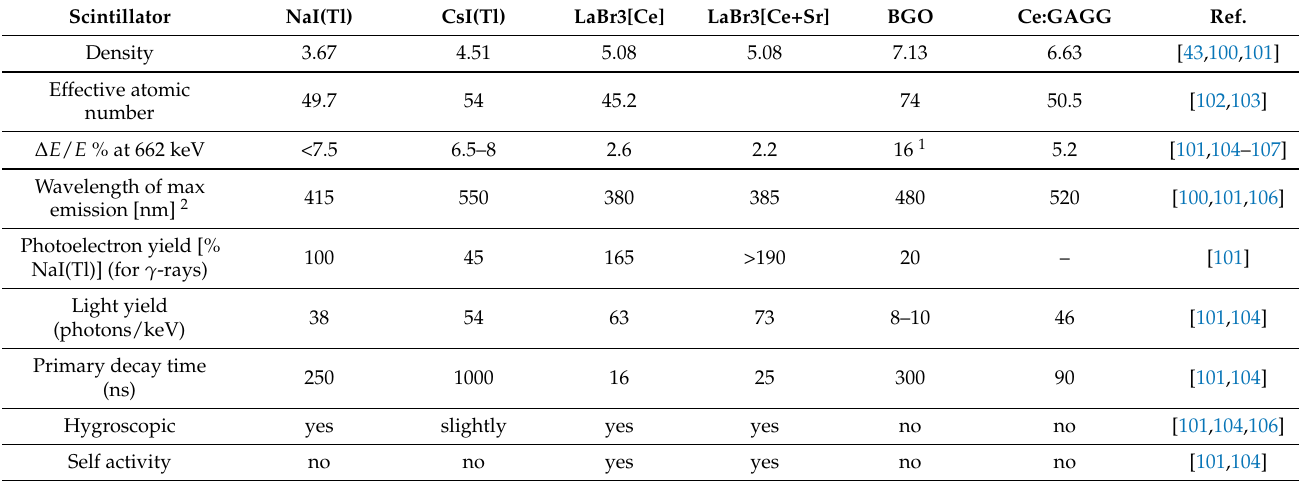
Table 3. Resume of the inorganic scintillation crystal main